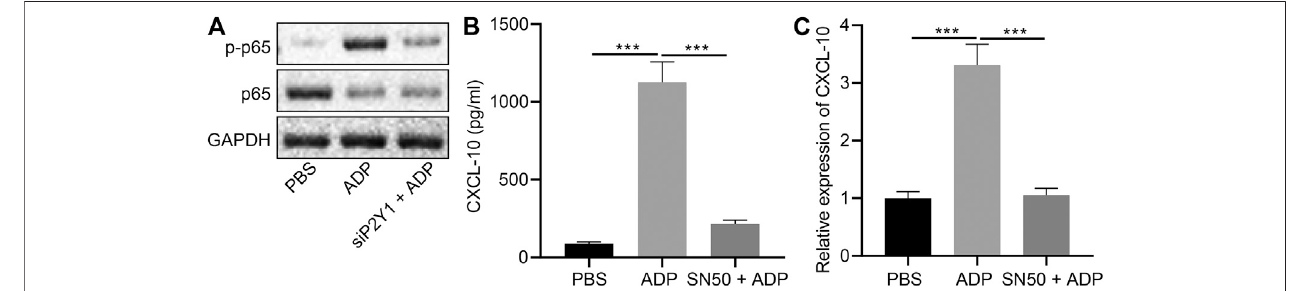
FIGURE7| ExtracellularADPactivatesNF- κ Bsignalingpathway. (A) Phosphorylationofp65afterP2Y1knockdownortreatmentwithADP. (B) releaseofCXCL10 in the SW1573 cells after SN50 treatment (1 h) and ADP treatment (12 h). (C) Quantitative analysis of the expression of CXCL10 in the SW1573 cells after SN50